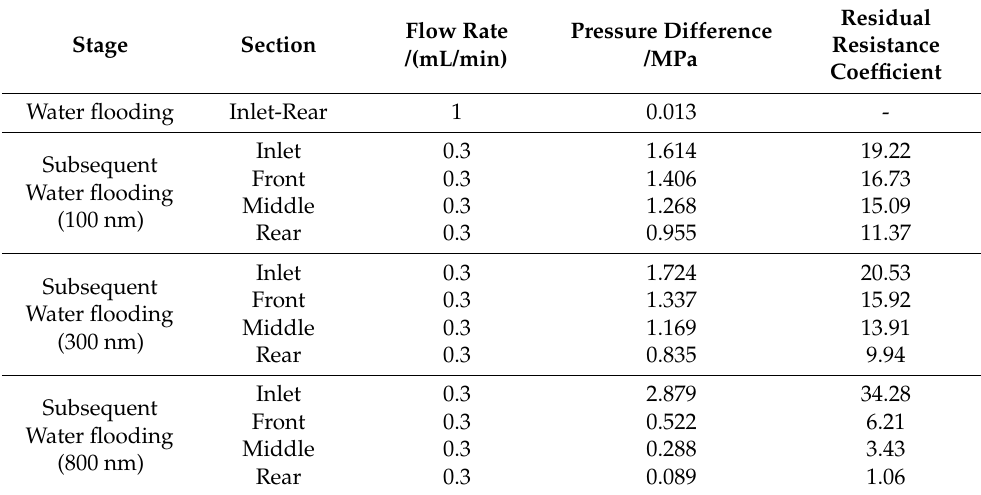
Table 7. Residual resistance coefficient of nanospheres with different particle